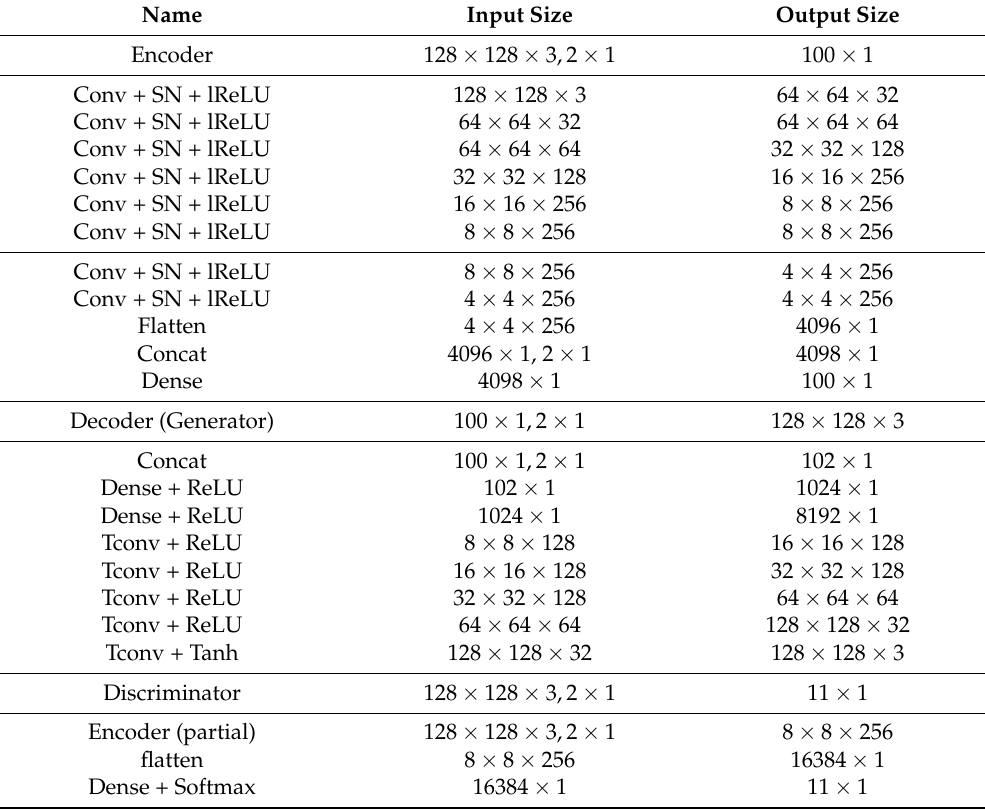
Table 1. Network architectures for the CelebA dataset (128 × 128 × 3). The slopes of all lReLU functions were set to